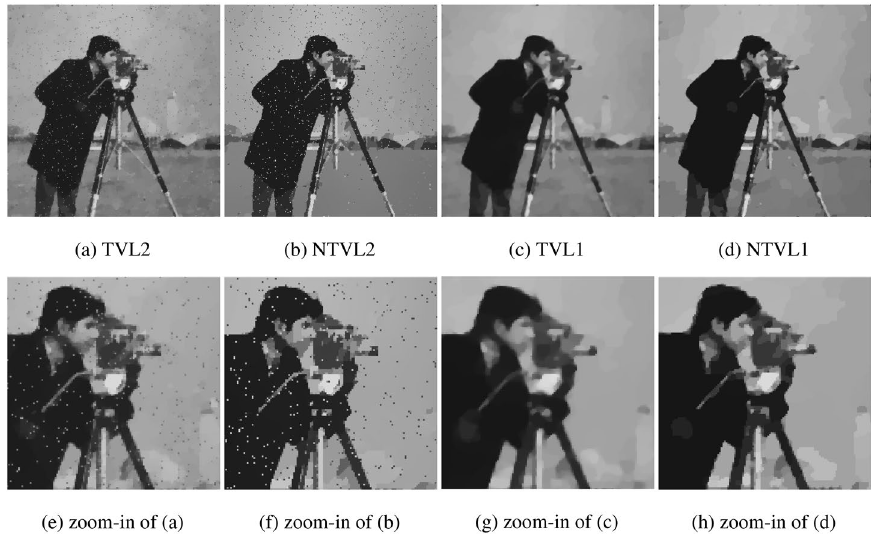
Figure 9. The denoising results of Cameraman contaminated by Gaussian noise ( σ = 0.015 ) and salt and pepper noise ( d = 0.04 ).